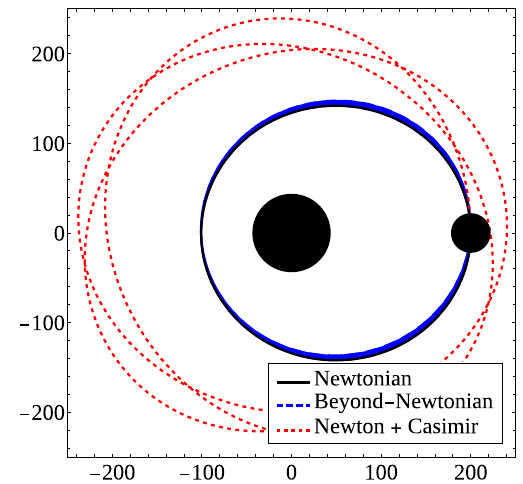
Fig. 19 Trajectory of S around P under the effect of Newton’s gravita- tional force (black solid line), Newton’s force plus the electric Casimir force for conductor-insulator spheres (red dotted line) , and a Beyond- Newtonian force with λ = 10 μ m and α = 2 (blue dashed line). The Planet and the Satellite are depicted by black dots with R P = 43 . 7 μ m